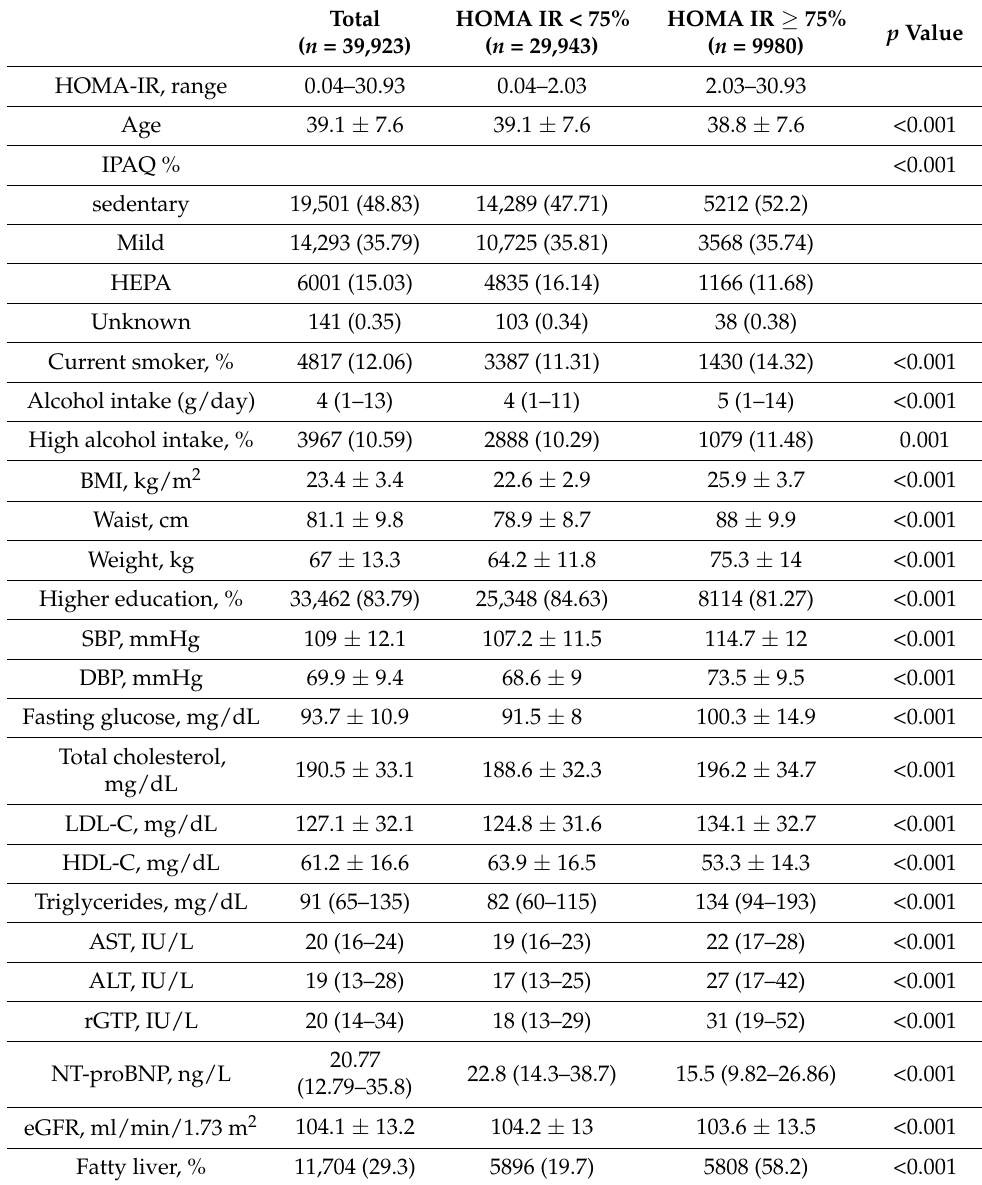
Table 2. Baseline characteristics according to HOMA-IR